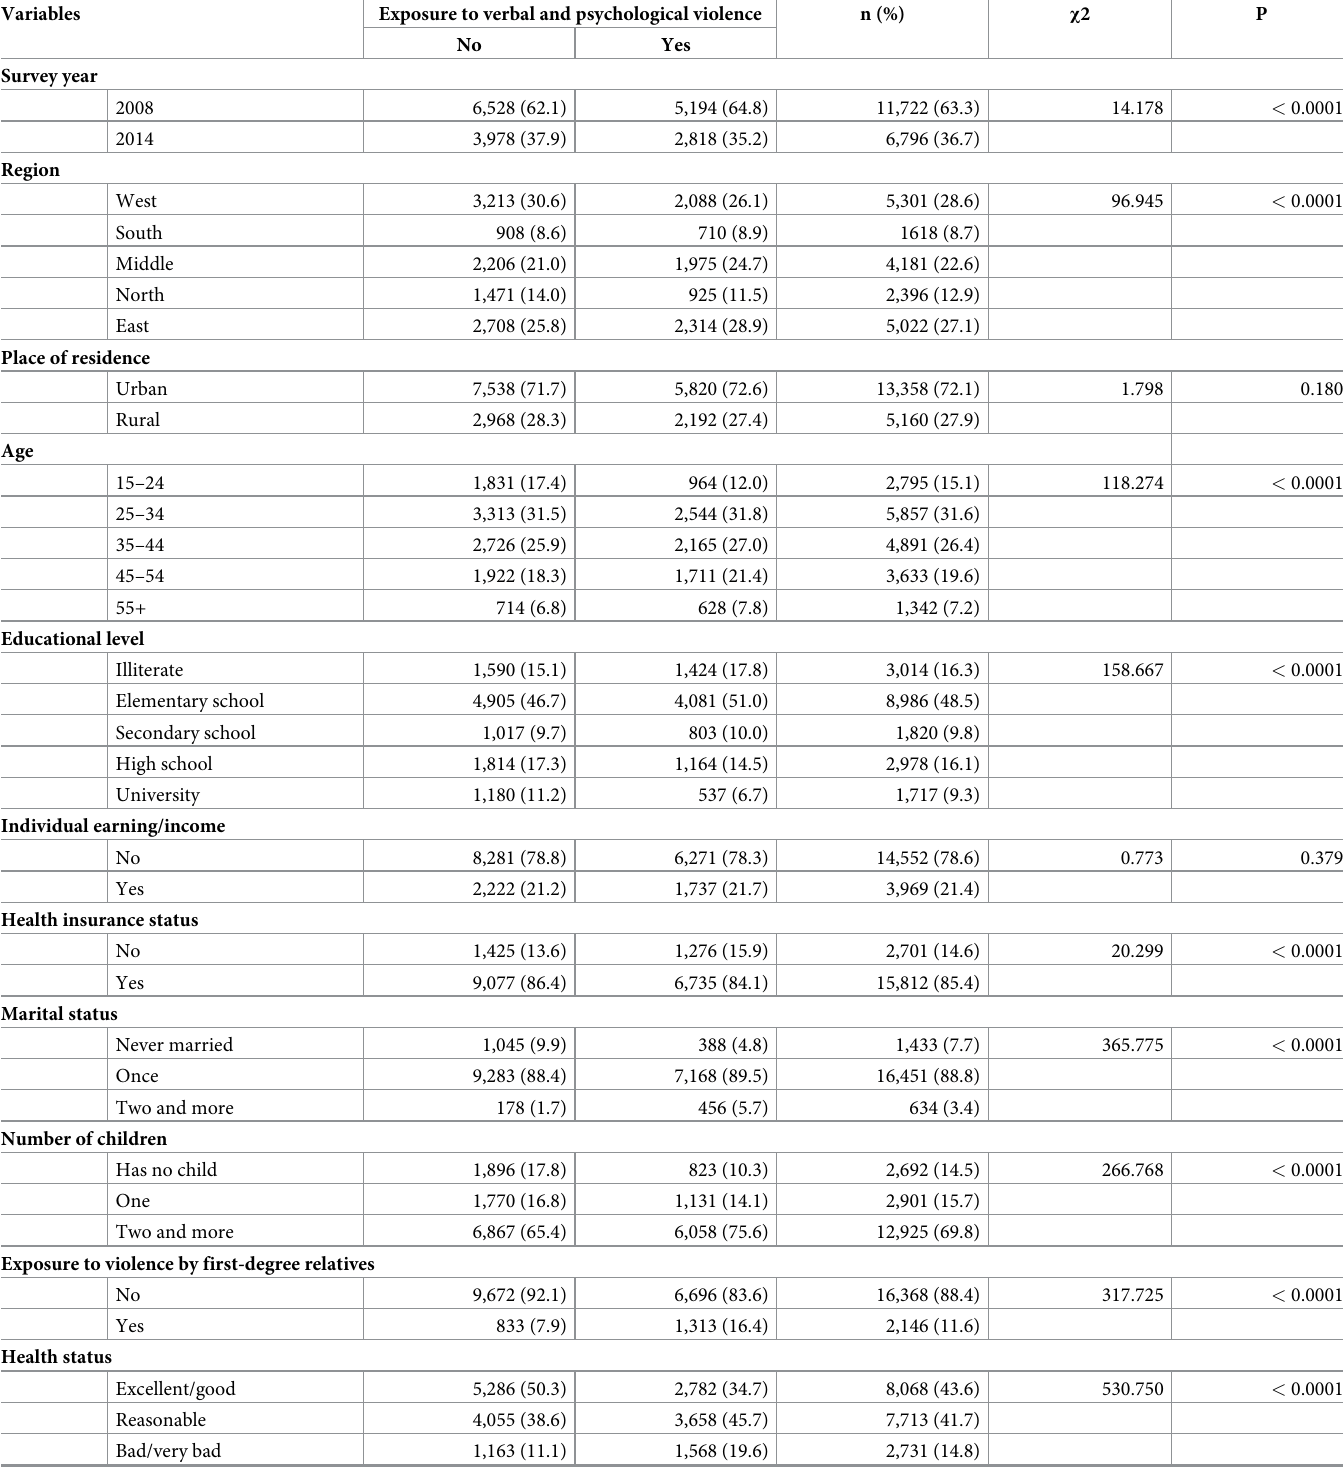
Table 1. Findings related factors affecting women’s exposure to verbal and psychological